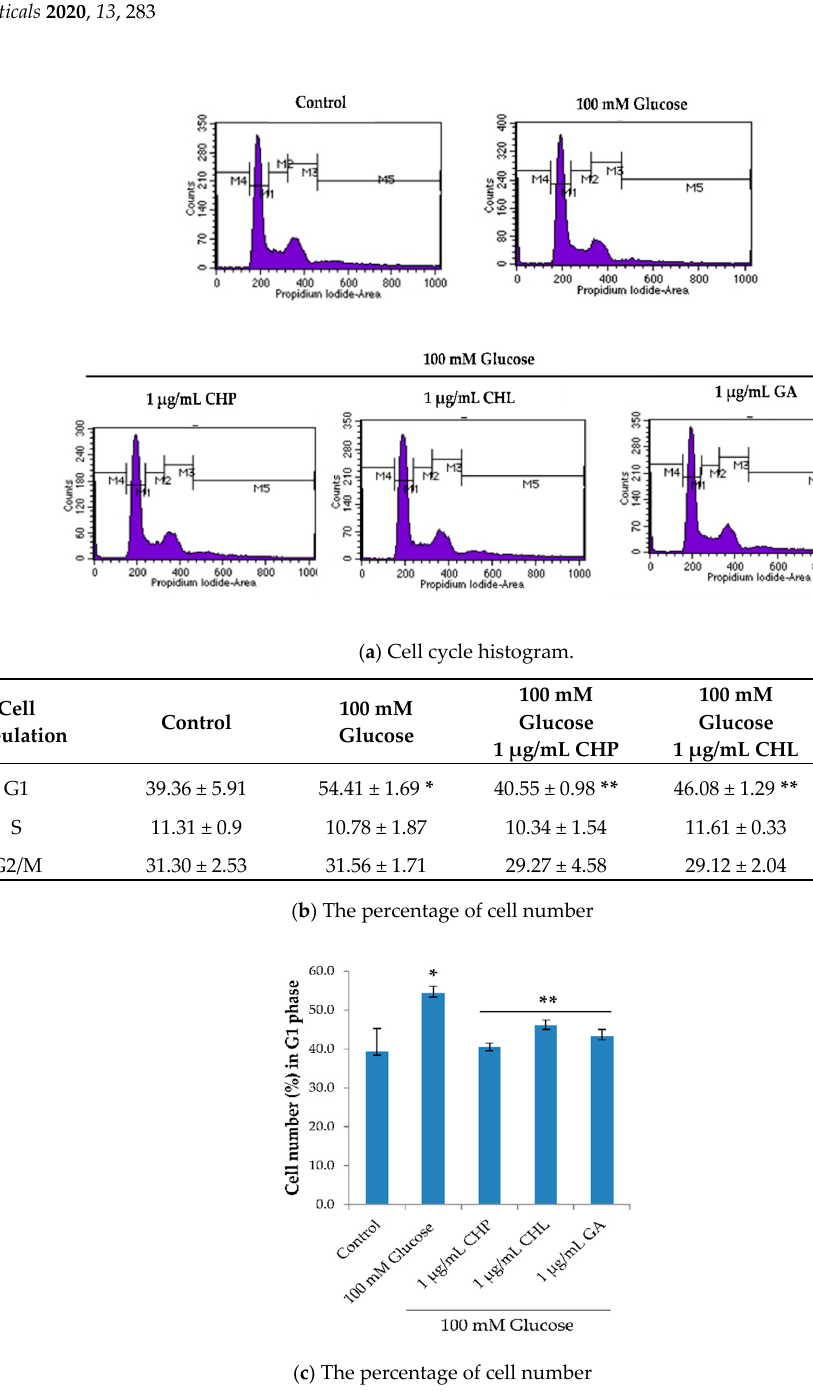
Figure 7. The effect of extracts on the cell cycle. Quantitative determination based on propidium iodide (PI) staining was carried out using a flow cytometer. The results showed ( a ) cell cycle histogram, ( b , c ) the percentage of cell numbers. Data are presented as the means ± SD, * p < 0.05 vs. control; ** p < 0.05 vs. 100 mM glucose alone. p values were 0.001, 0.001, 0.039 and 0.007 for 100 mM glucose, CHP, CHL and GA, respectively.